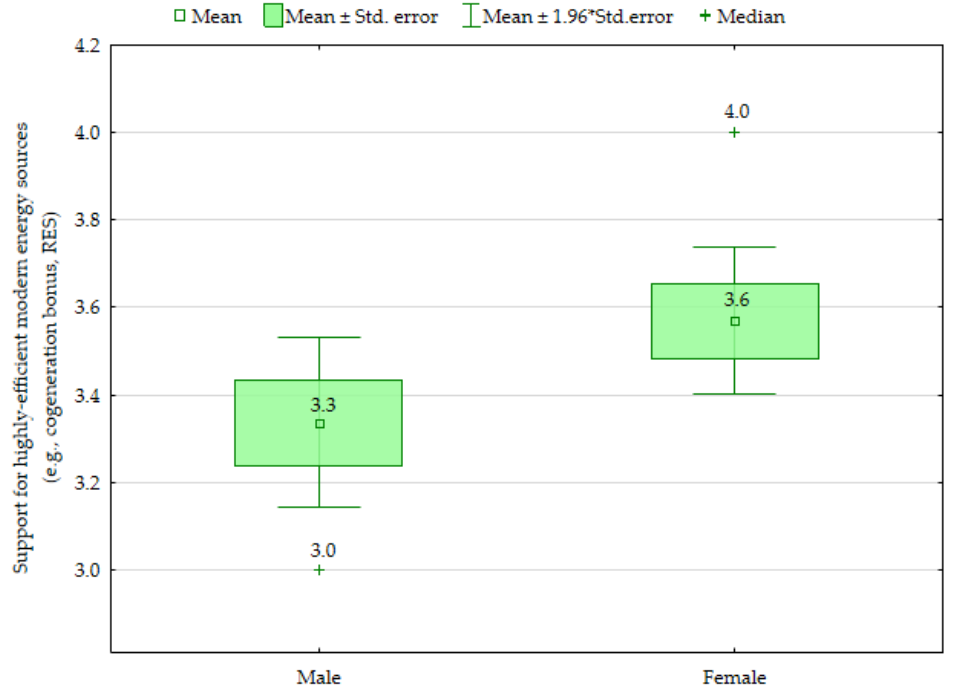
Figure 7. Gender and the assessment of energy compensation. Storage of production by day, receiving at night. Source: Own elaboration based on the conducted research, n = 444.